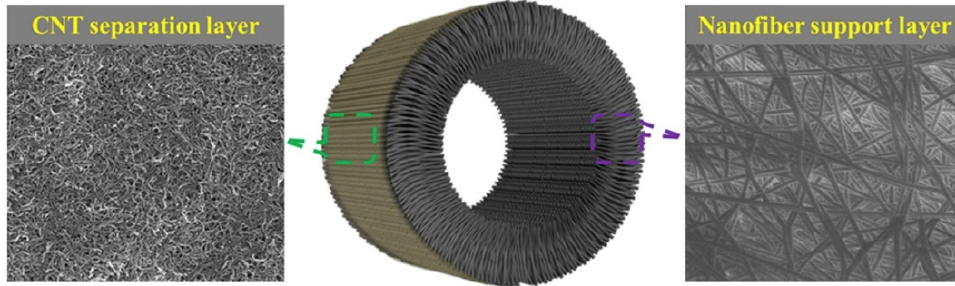
Figure 10. Images of conductive CNT/nanofiber composite hollow fiber membrane with electrospun support layer. Diagram taken from [109].